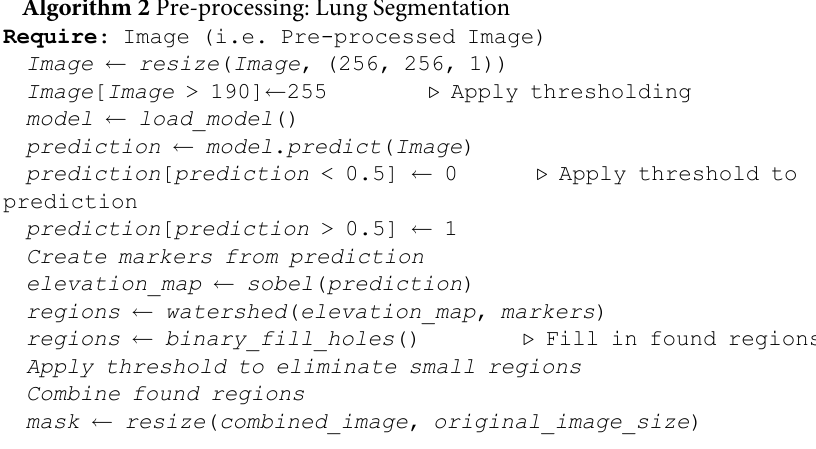
Algorithm 2 Pre-processing: Lung